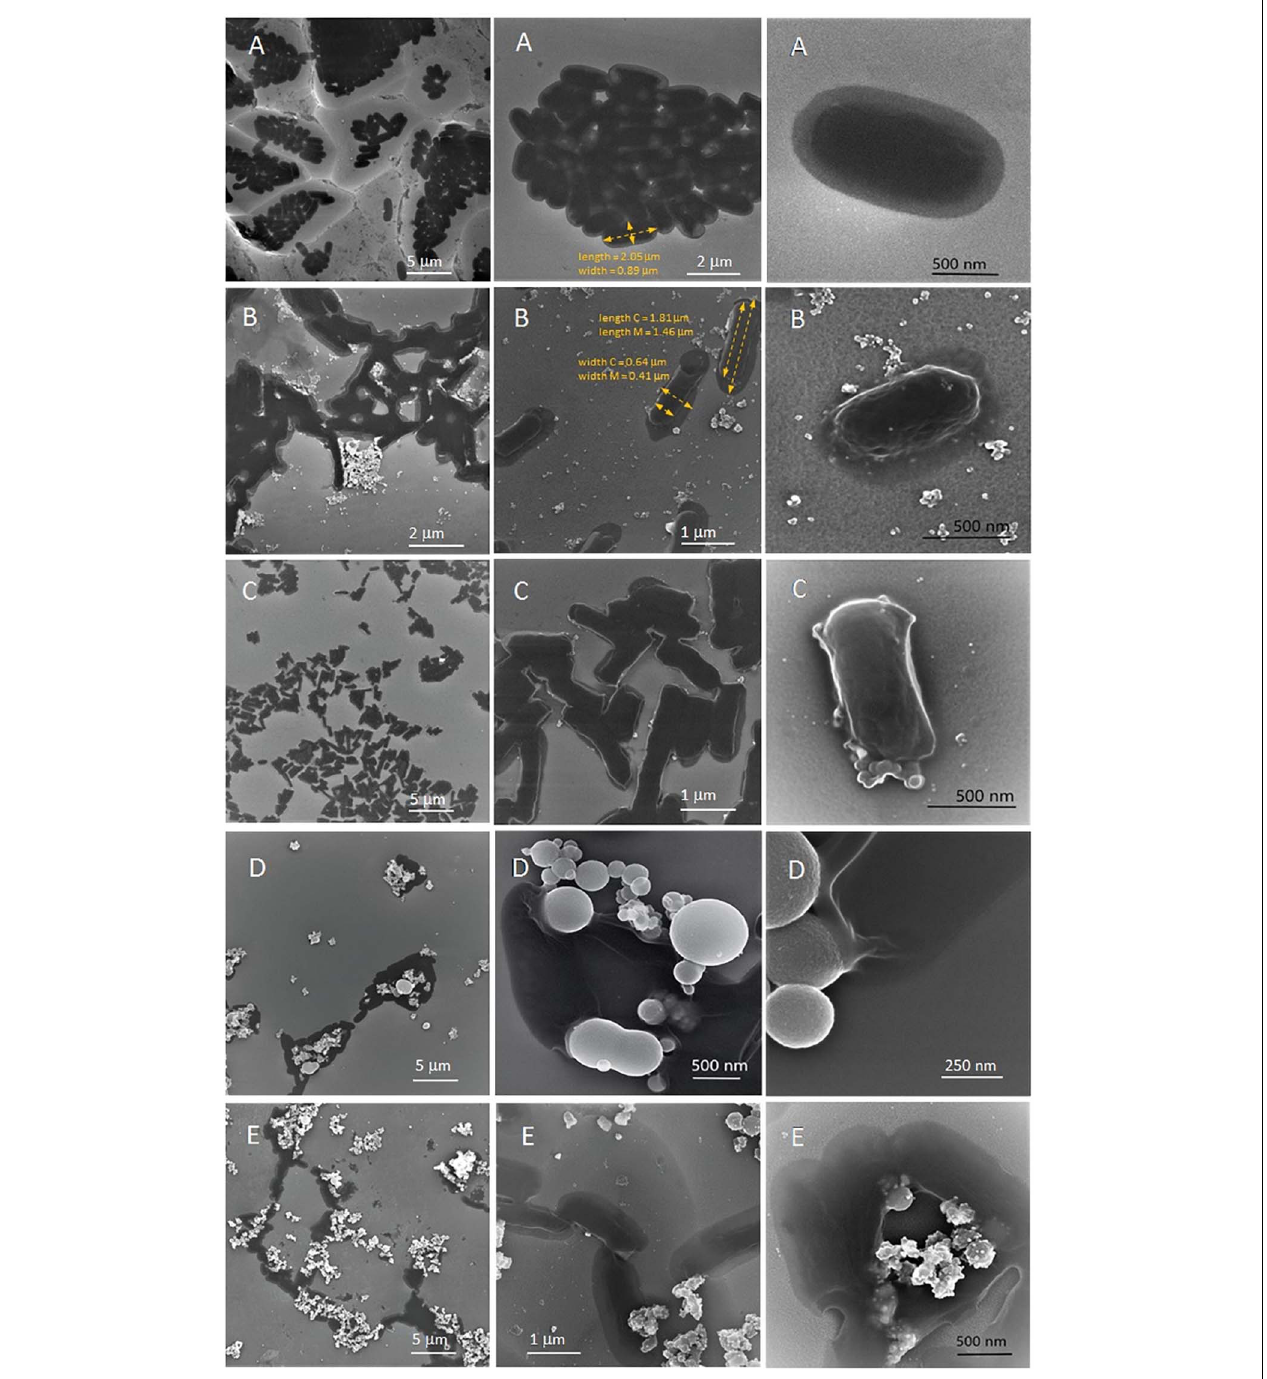
FIGURE 3 | FE-SEM micrograps and quatified results on E. coli BW25113 bacteria before (A) and after treatment with silver ions or silver nanoformulation S2 or S7 (B–E) : Ag + (B) , S7 (C) , pure TiO 2 (silver carrier) (D) and S2 (E) . Legend: (A) Length = 2.10 ± 0.28 µ m, Width = 0.81 ± 0.06 µ m, oval shape, smooth surface; (B) Length C = 1.64 ± 0.19 µ m, Width C = 0.61 ± 0.04 µ m, Length M = 1.20 ± 0.16 µ m, Width M = 0.43 ± 0.03 µ m, distinctive structure with rough surface, flat area of the capsule, three-dimensional inner part surrounded by the cytoplasmic membrane area; (C) Length = 1.32 ± 0.15 µ m, Width = 0.41 ± 0.04 µ m, Length C = 1.38 ± 0.15 µ m, Width C = 0.49 ± 0.05 µ m, Length M = 1.29 ± 0.13 µ m, Width M = 0.43 ± 0.05 µ m, rectangular shape, distinctive structure with rough surface, in the case of some bacteria flat area of the capsule, three-dimensional inner part surrounded by the cytoplasmic membrane area; (D) Length = 1.74 ± 0.25 µ m, Width = 0.78 ± 0.04 µ m, oval shape, smooth surface; (E) Length C = 1.75 ± 0.26 µ m, Width C = 0.80 ± 0.06 µ m, Length M = 1.34 ± 0.24 µ m, Width M = 0.45 ± 0.05 µ m, distinctive structure with rough surface, flat area of the capsule, three-dimensional inner part surrounded by the cytoplasmic membrane